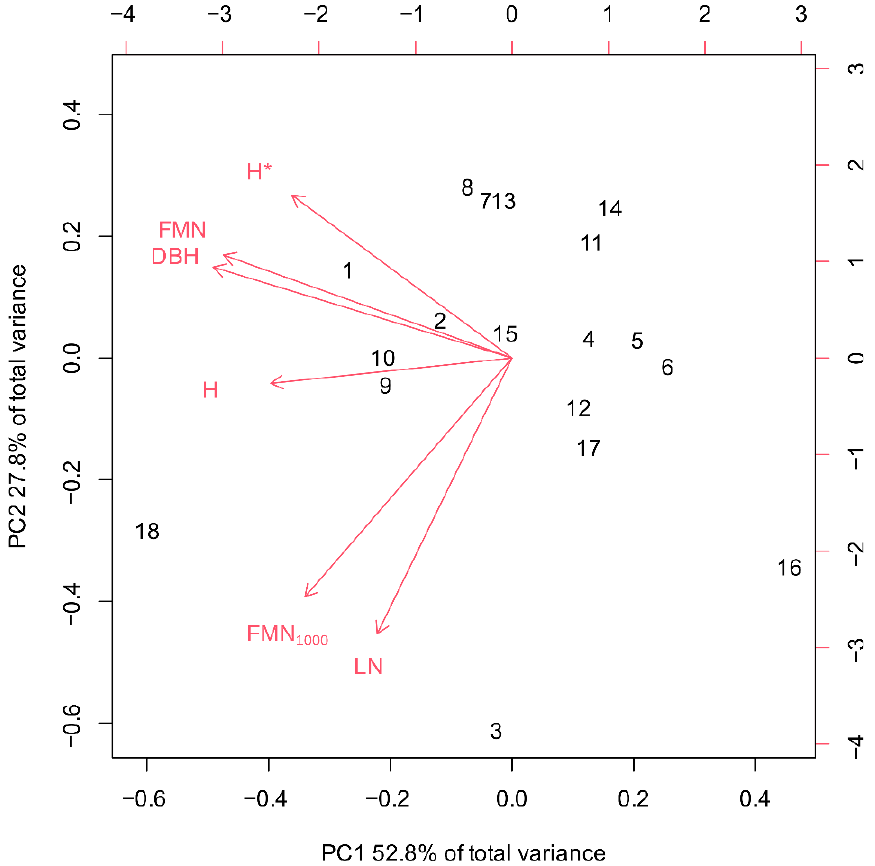
Figure 3. Biplot illustrating PCA-derived relationships between the scaled sample tree parameters (DBH, H, H*, FMN, FMN 1000 , LN).